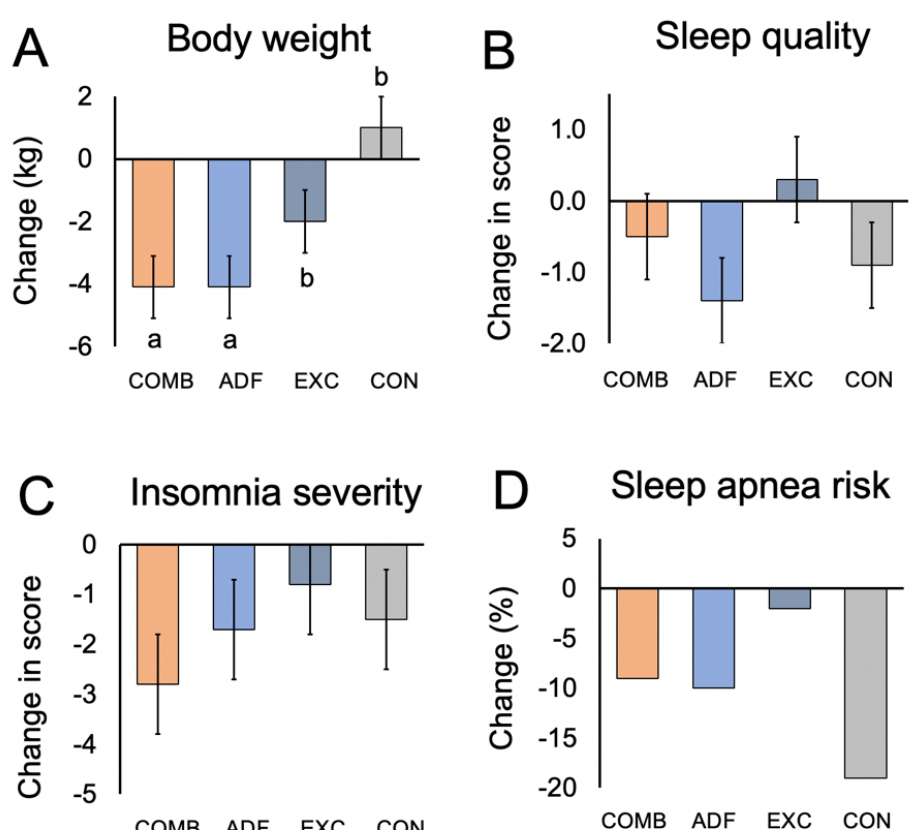
Figure 1. Change in body weight, sleep quality, insomnia severity, and risk of obstructive sleep apnea after 3 months of intervention. Continuous variables reported as mean ± SEM. Risk of obstructive sleep apnea reported as % occurrences. Comb: combination group; ADF: alternate-day fasting group; Exc: exercise group; Con: control group. Means with different superscript letters are significantly different using repeated measures ANOVA ( p < 0.05, group × time interaction). ( A ) By month 3, body weight decreased ( p < 0.01, group × time interaction) in the combination group versus the exercise group and controls, but not versus the ADF group. ( B ) Sleep quality (PSQI) score did not change in the intervention groups versus controls (no group × time interaction). ( C ) Insomnia severity did not change in the intervention groups versus controls (no group × time interaction). ( D ) Risk of obstructive sleep apnea did not change in the intervention groups versus controls (no group × time interaction).